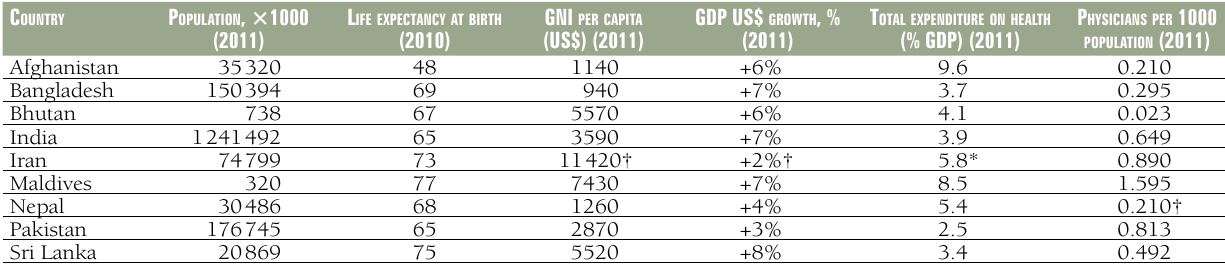
Table 2. Southern Asia countries – selected characteristics